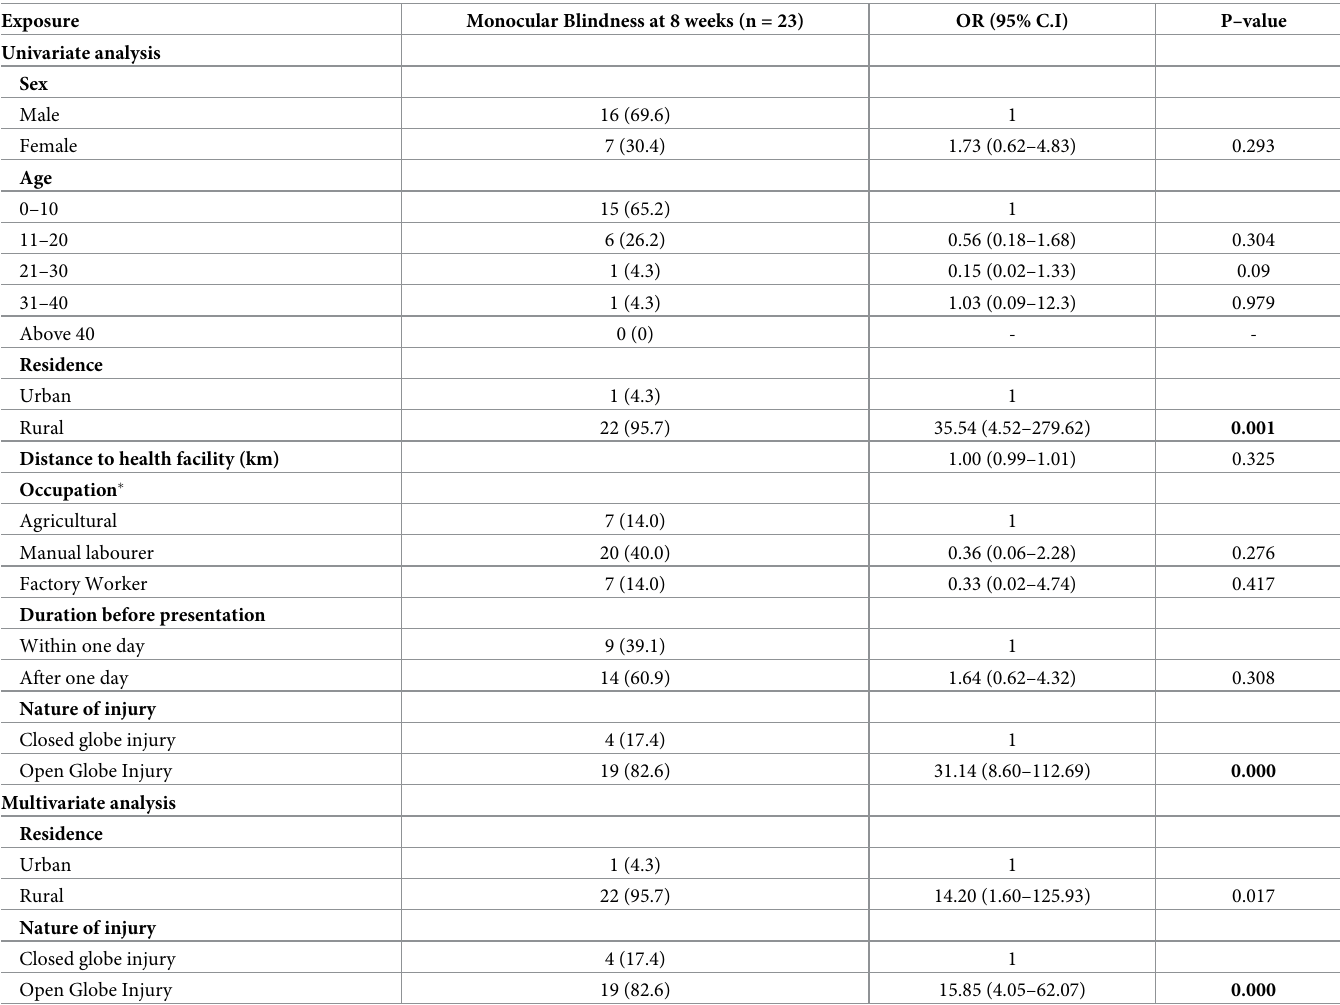
Table 6. Factors associated with developing monocular blindness at 8